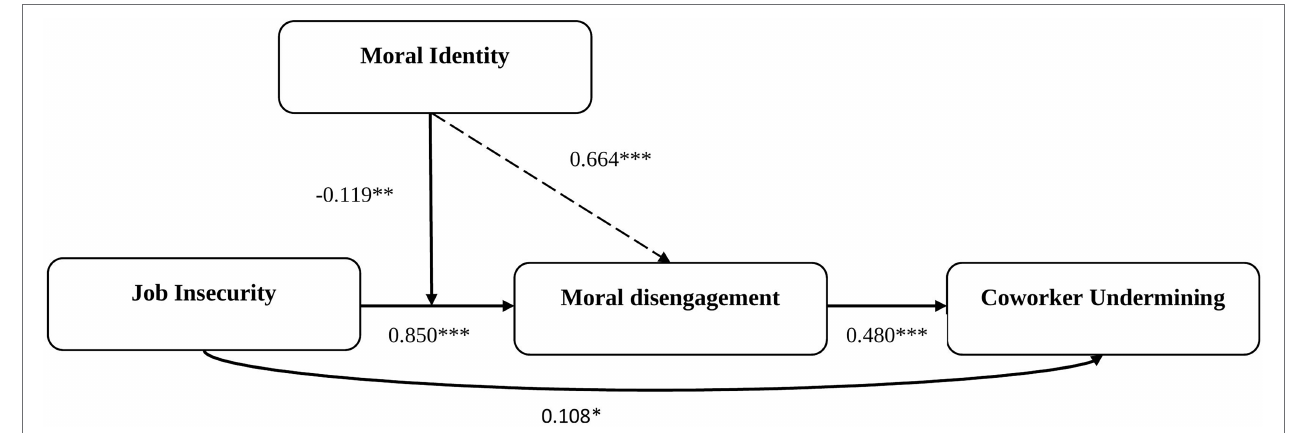
FIGURE 2 | Results of moderated-mediation model. The Solid lines show the Hypothesized relationship; Statistically significant at: *** p < 0.0001, ** p < 0.001, * p <